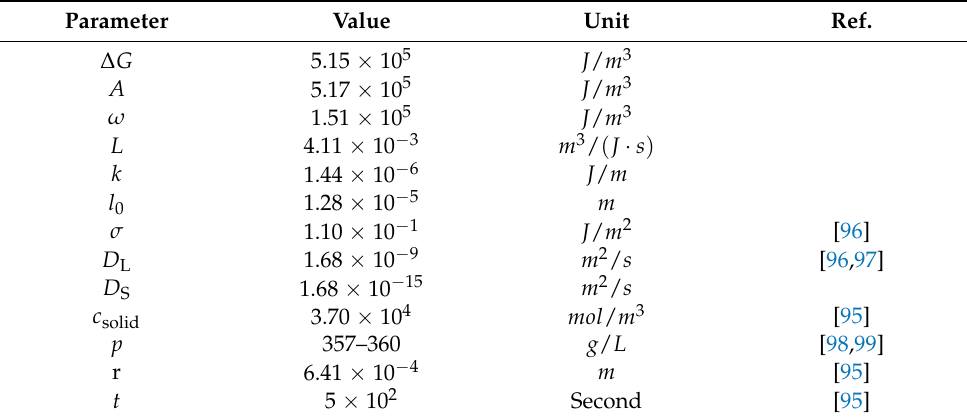
Table 2. Model parameters for diffusion-controlled NaCl dissolution.